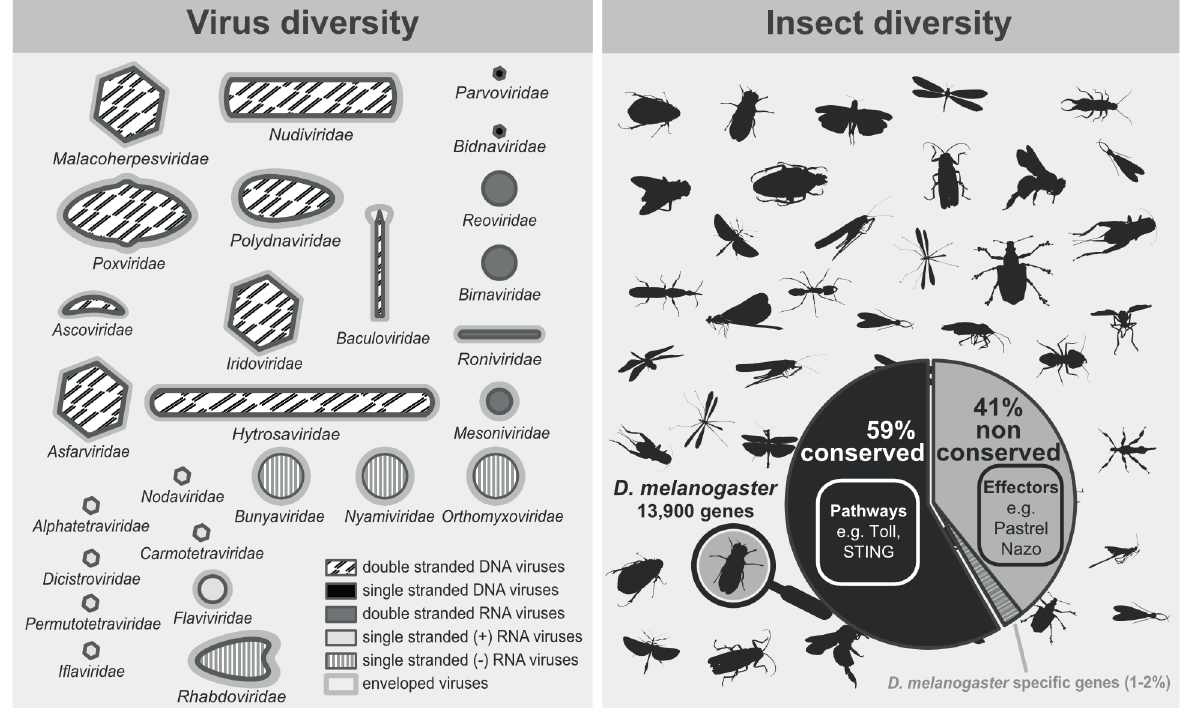
Figure 1 - Diversity of insects and viruses. A plethora of known insect viruses and insect hosts is depicted on the left and right panels, respectively. Insects broadly evolved to resist infection, so investigating the evolutionarily conserved antiviral strategies in these animals can shed light on new host factors and restriction factors that affect viral infection. The pie chart represents the percentage of D. melanogaster genes that are conserved or non-conserved in the human genome. D. melanogaster exclusive genes are highlighted among the non-conserved genes. Adapted from Martins et al.